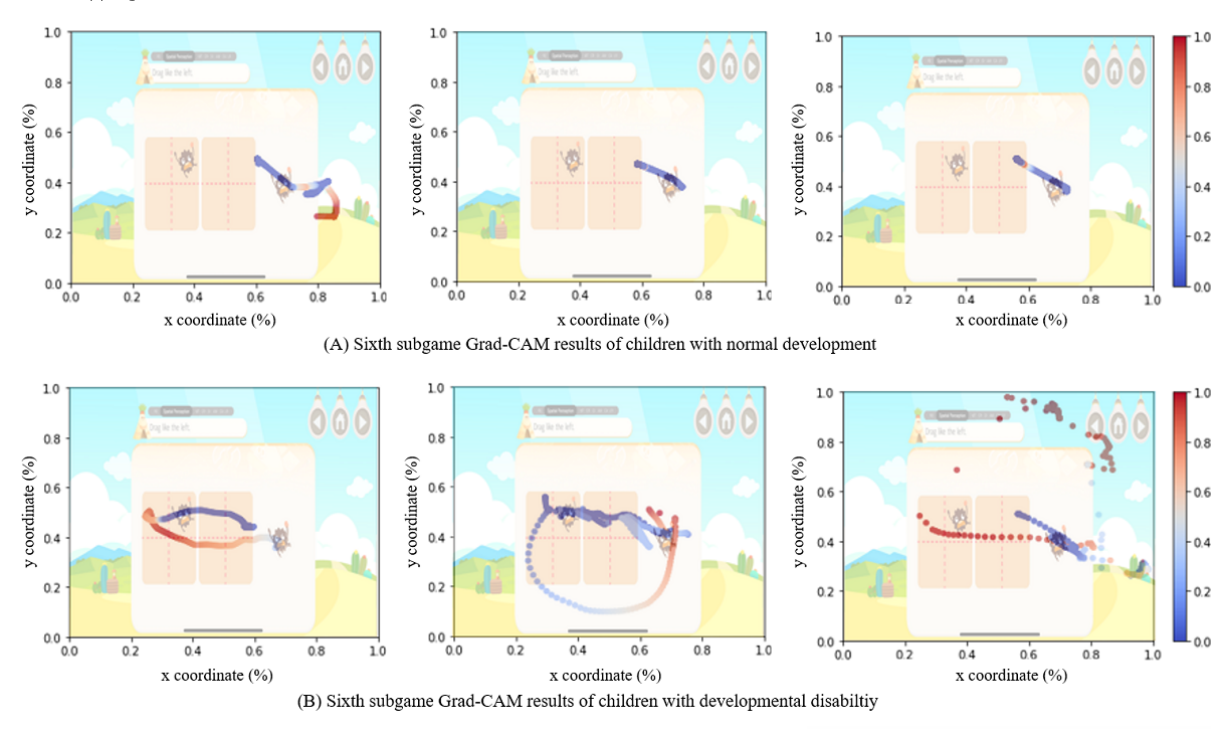
Figure 4. Sixth subgame with Grad-CAM results of children with normal and abnormal development disability. Grad-CAM: gradient-weighted class activation